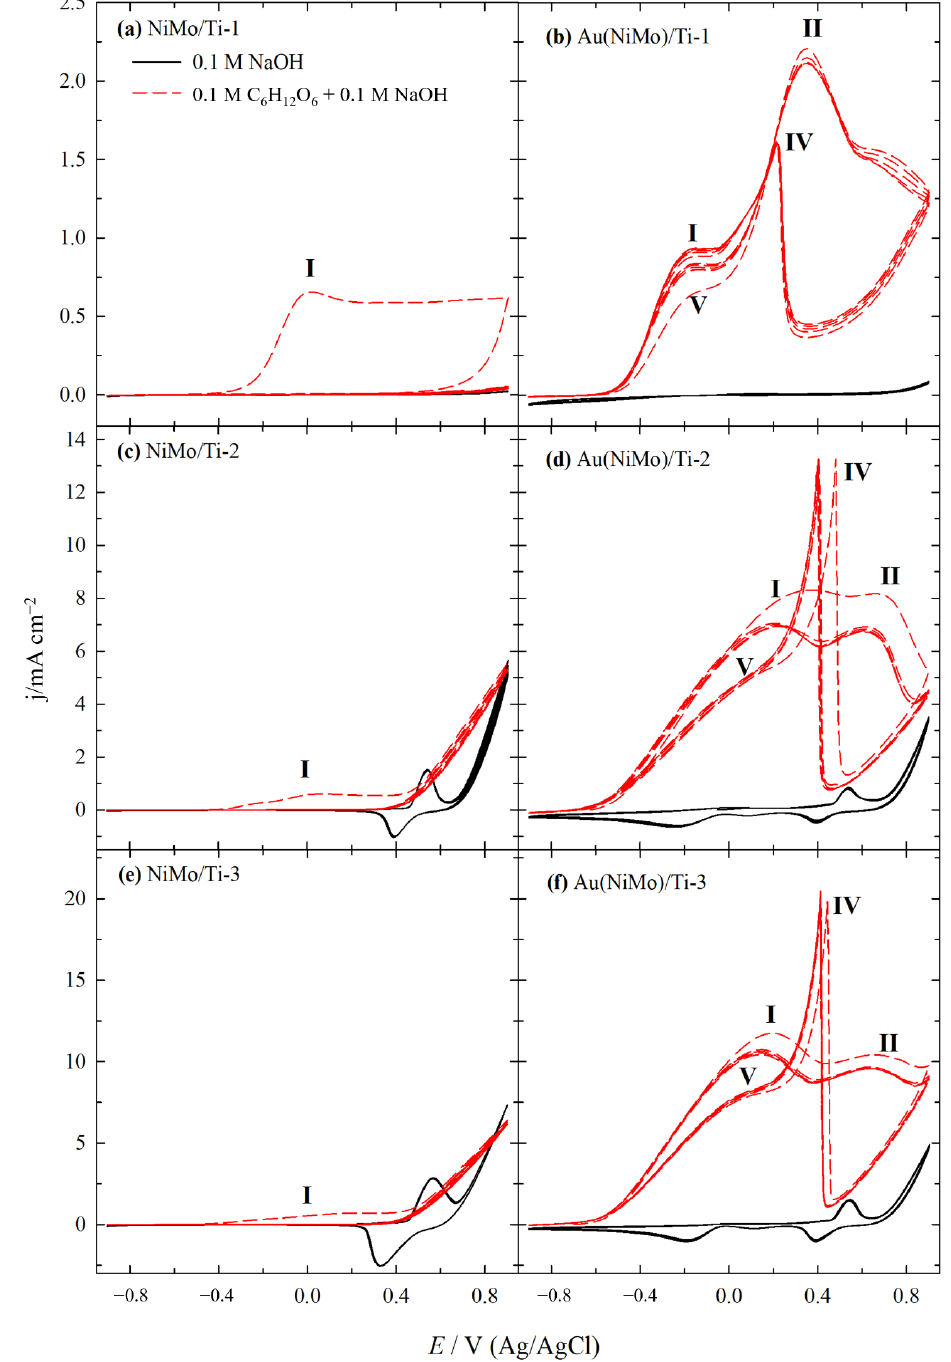
Figure 6. Cyclic voltammograms recorded on NiMo/Ti ( a , c , e ) and Au(NiMo)/Ti ( b , d , f ) catalysts in the 0.1 M NaOH solution (solid line) and that containing 0.1 M glucose (dashed line) at 25 °C at an electrode potential scan rate of 50 mV s − 1 .